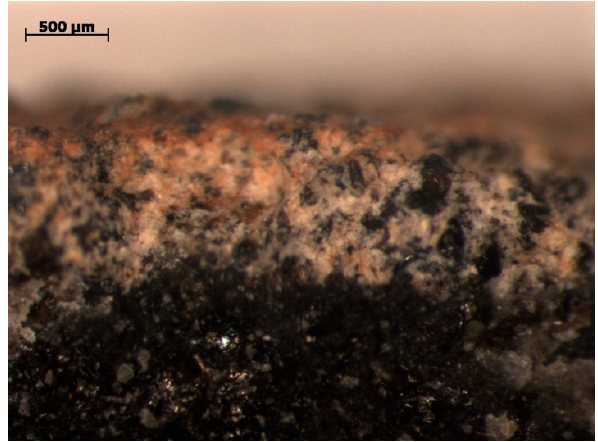
Figure 1. Halloyiste sample with visible transformation from basalt rock (LM).